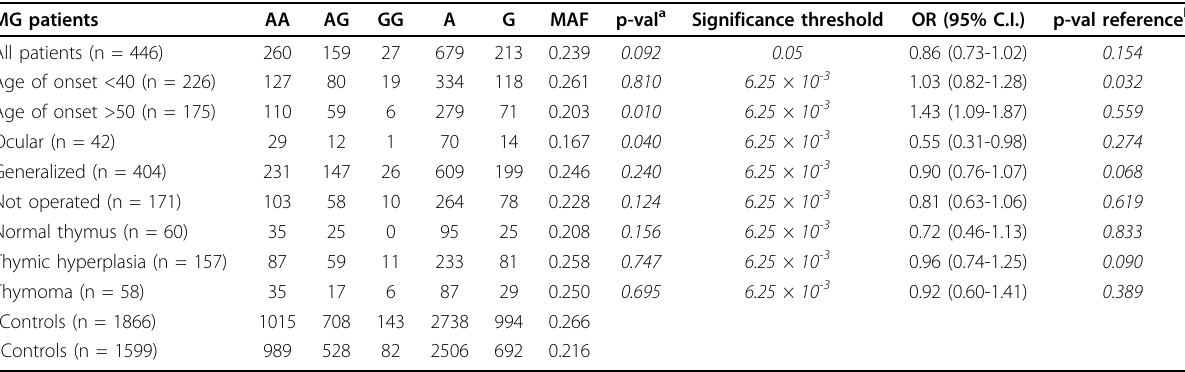
Table 1 Results of CIITA genotyping in MG patients and controls MG